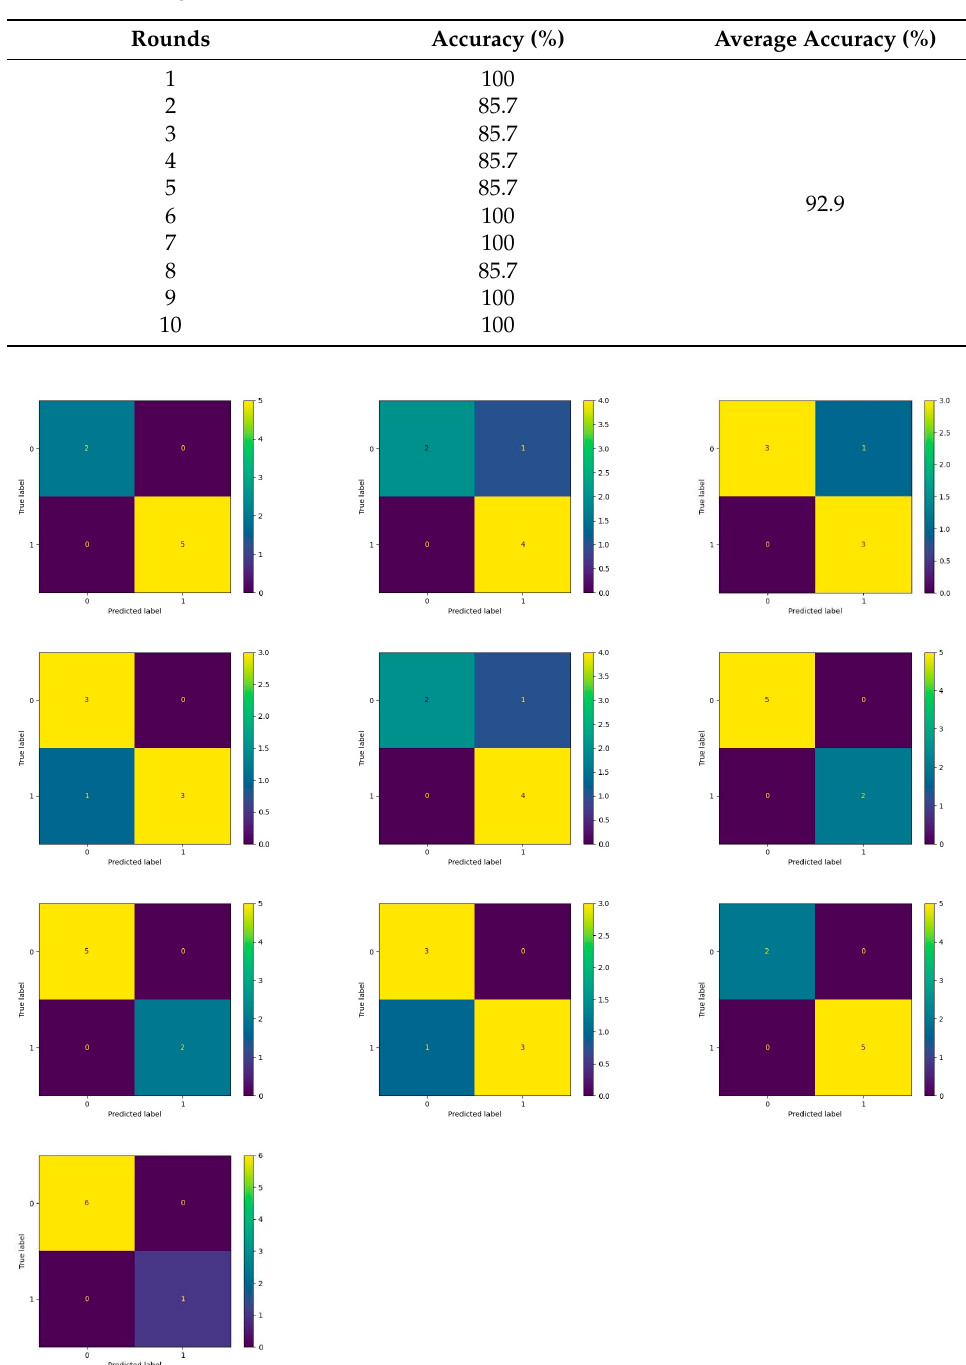
Table 3. The recognition accuracies under food or medicine classification scale.